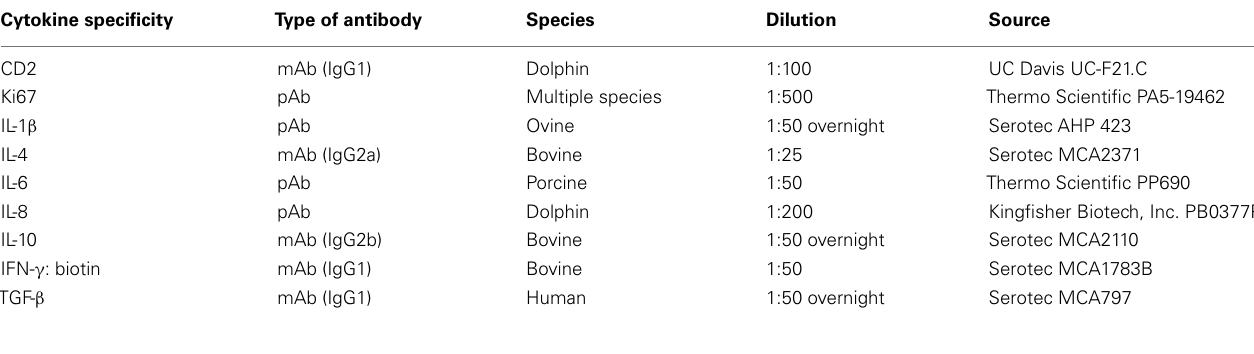
Table 1 | Primary antibodies used for fluorescent